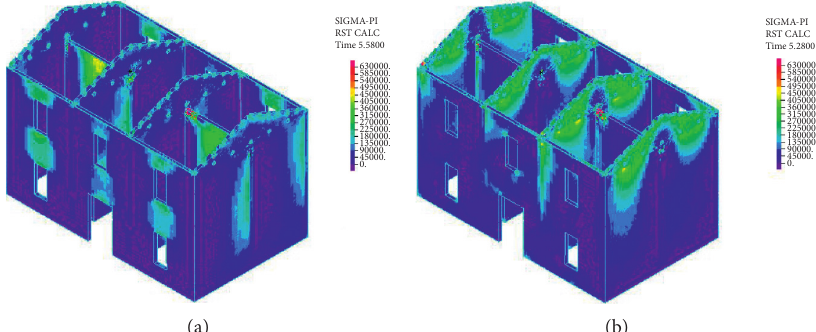
Figure 12: Cloud diagram of the maximum main tensile stress of the wall under EL-Centro earthquake (0.2g). (a) X -direction. (b) Y